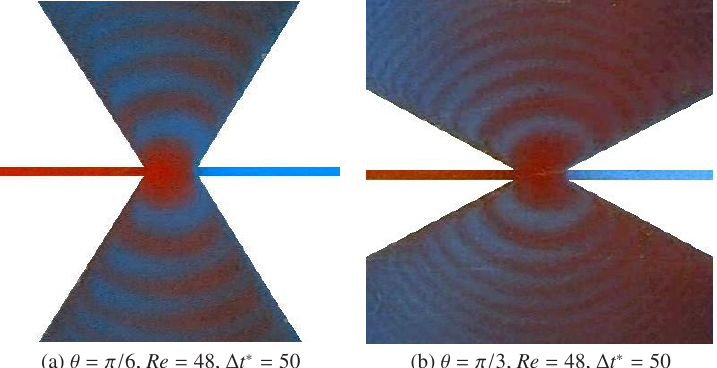
Fig. 10 Layered flow patterns generated in asterisk-shaped channels.